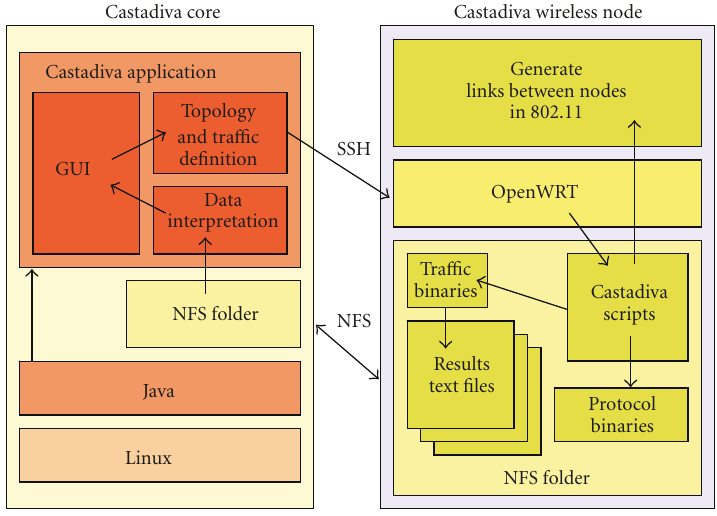
Figure 4: Software components for Castadiva .